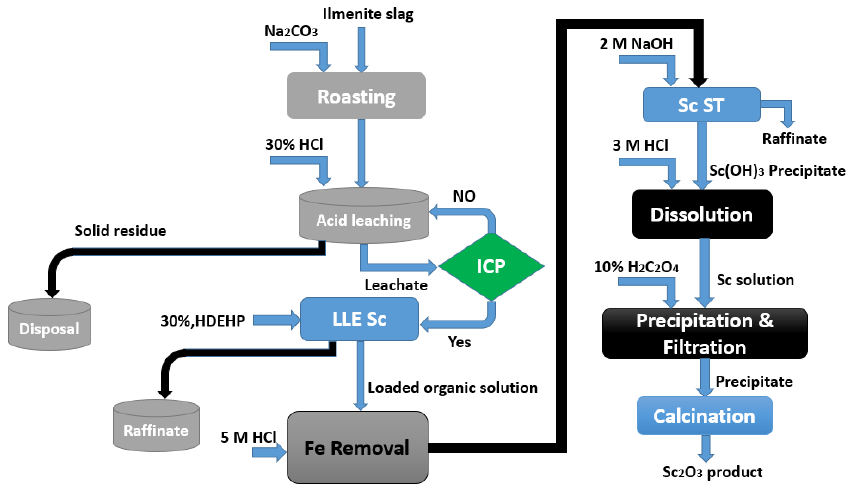
Figure 9. The process of scandium recovery from the ilmenite slag, adapted from [111]. The process comprised the grinding of the slag, its roasting it with Na 2 CO 3 at approximately 950 ◦ C, and, finally, leaching it with 30% HCl at 80 ◦ C and an S/L rate of 1:2. A total of 94% of the scandium was recovered from the leachate solution using kerosene containing 30% P204 at an A/O ratio of 20:1 and only 2.2% Fe co-extraction. Scrubbing with 5 mol/L HCl removed the extracted iron, while 2 mol/L NaOH recovered the scandium. After dissolving the scandium hydroxide precipitate in HCl, Sc was precipitated using oxalic acid. After heat treatment of the Sc 2 (C 2 O 4 ) 3 at 800 ◦ C, a high purity of 99% of the Sc 2 O 3 product was obtained. Feuling and et al. [112] obtained a patent for a procedure to recover Sc from a Ti chlorination residue using TBP as an extractant (Figure 10).